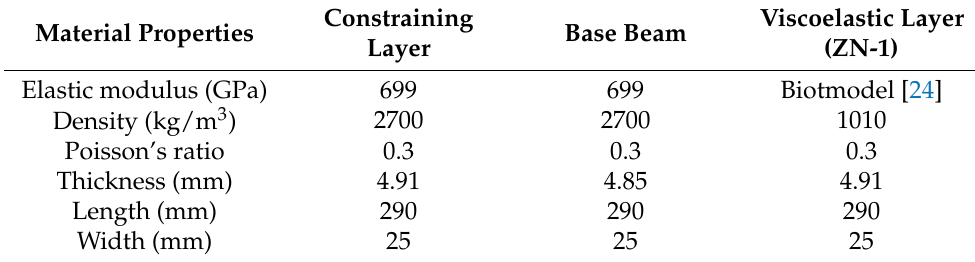
Table 1. Material parameters of experimental specimen.